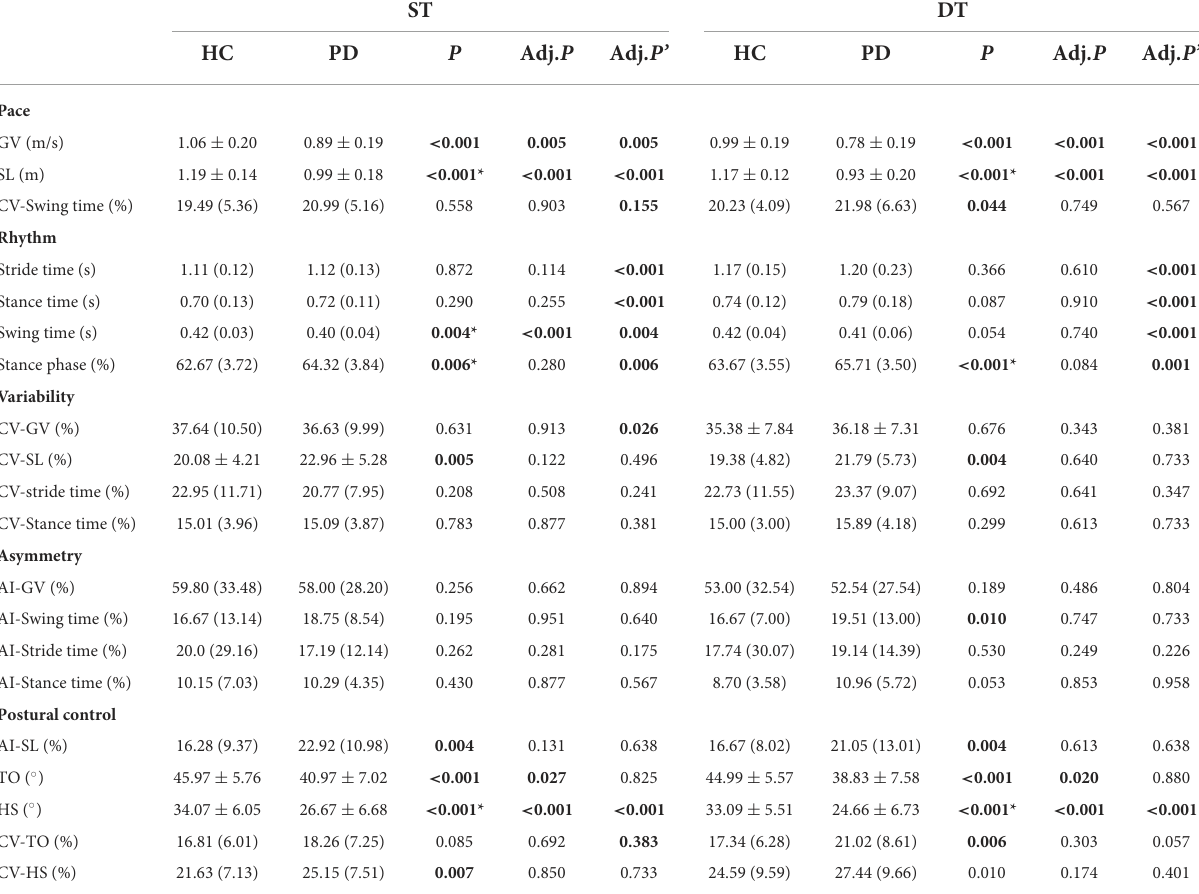
TABLE 4 Comparison of gait characteristics of patients with early-stage PD and healthy